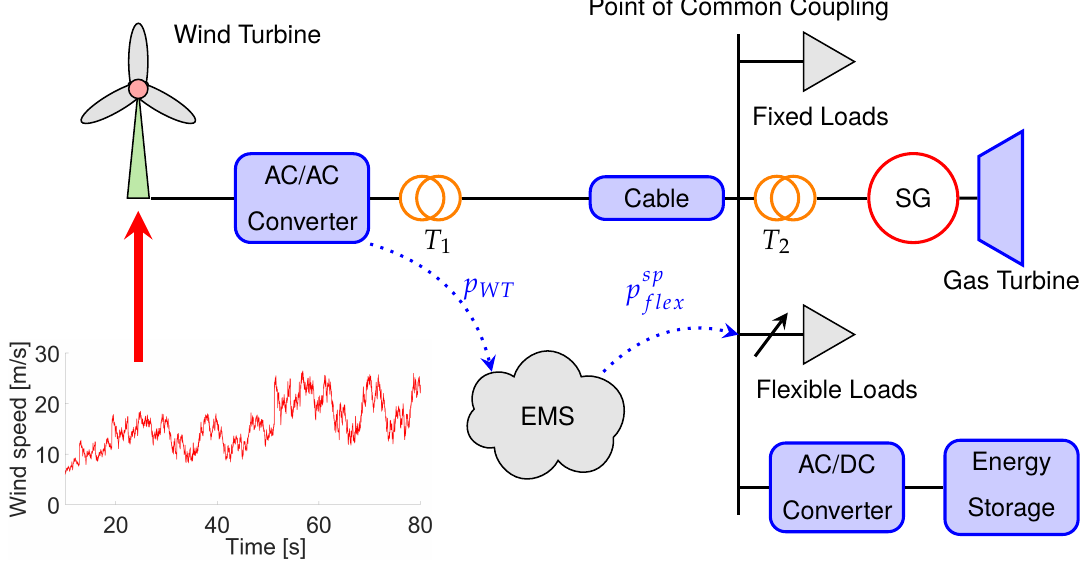
Figure 1. Main elements of the electric power system for a wind-powered